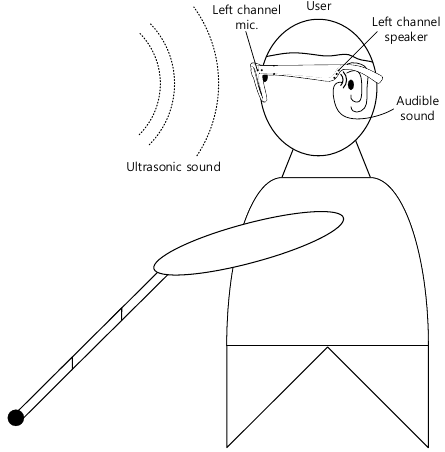
Figure 3. Example of an individual wearing the eyeglass receiver device.